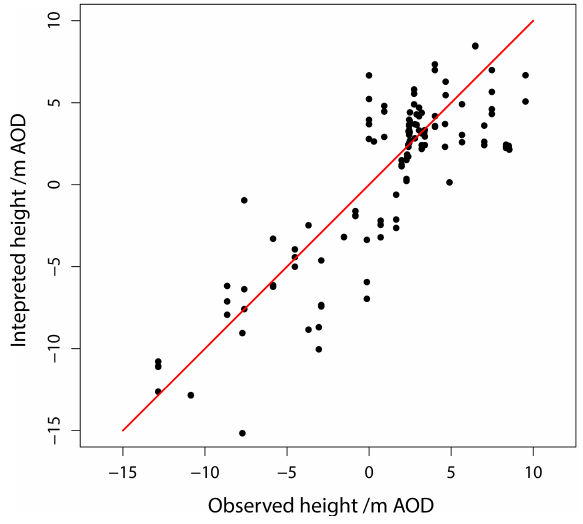
Figure 4. 95% probability interval for simulated cross-section er- rors conditional on the location of the nearest borehole (red symbol) and model 2a. Note that these are evaluated at discrete